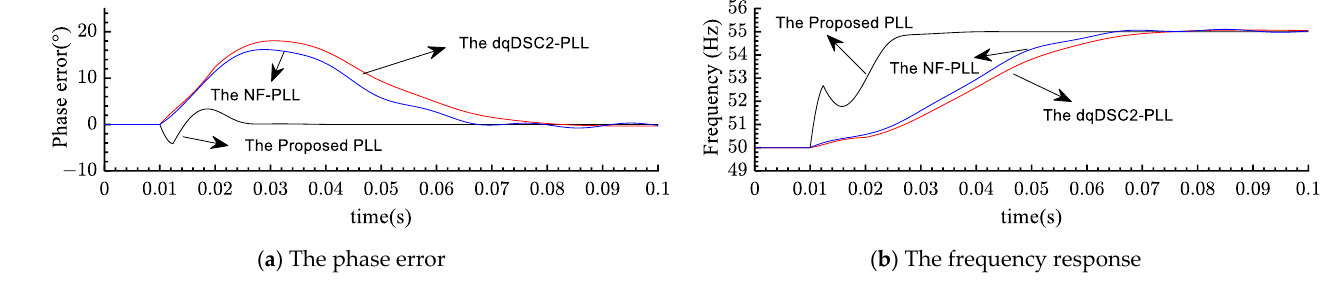
Figure 10. Comparisons between related PLLs under test 2 condition: ( a ) the estimated phase error; and ( b ) the estimated frequency.